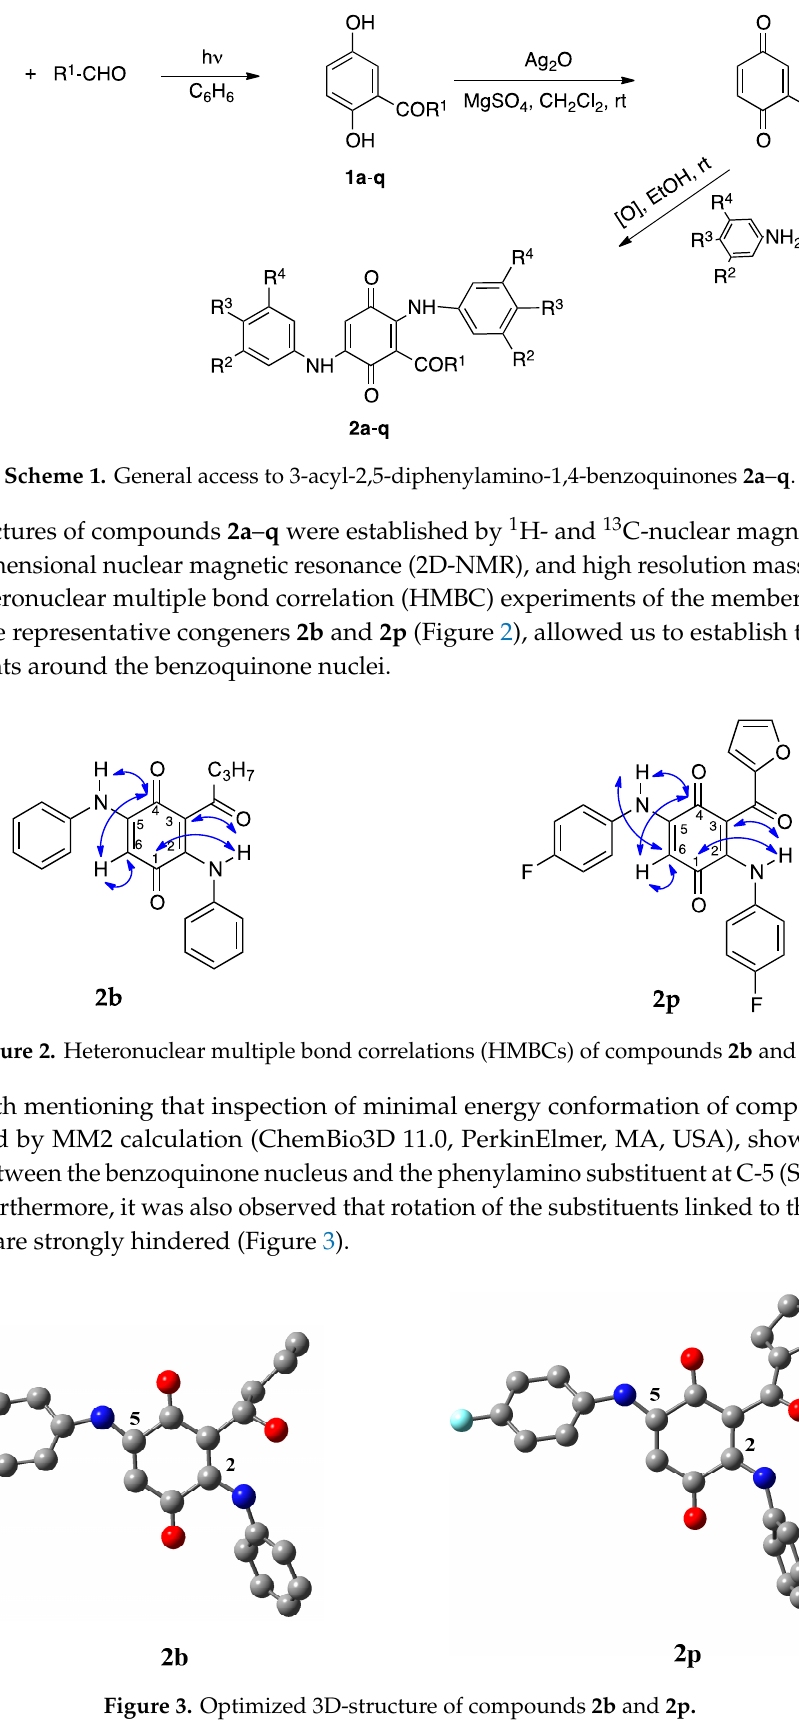
Figure 3. Optimized 3D-structure of compounds 2b and 2p.